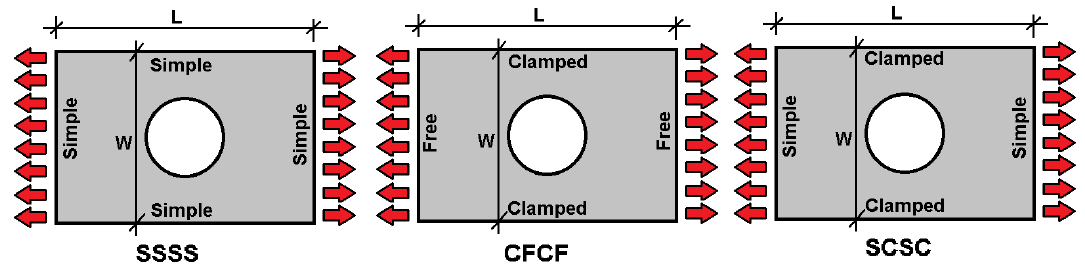
Figure 2. Support conditions of the steel plate.